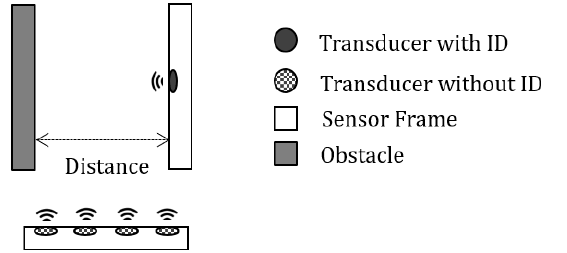
Figure 10. Arrangement of transducers and an obstacle for measurement.